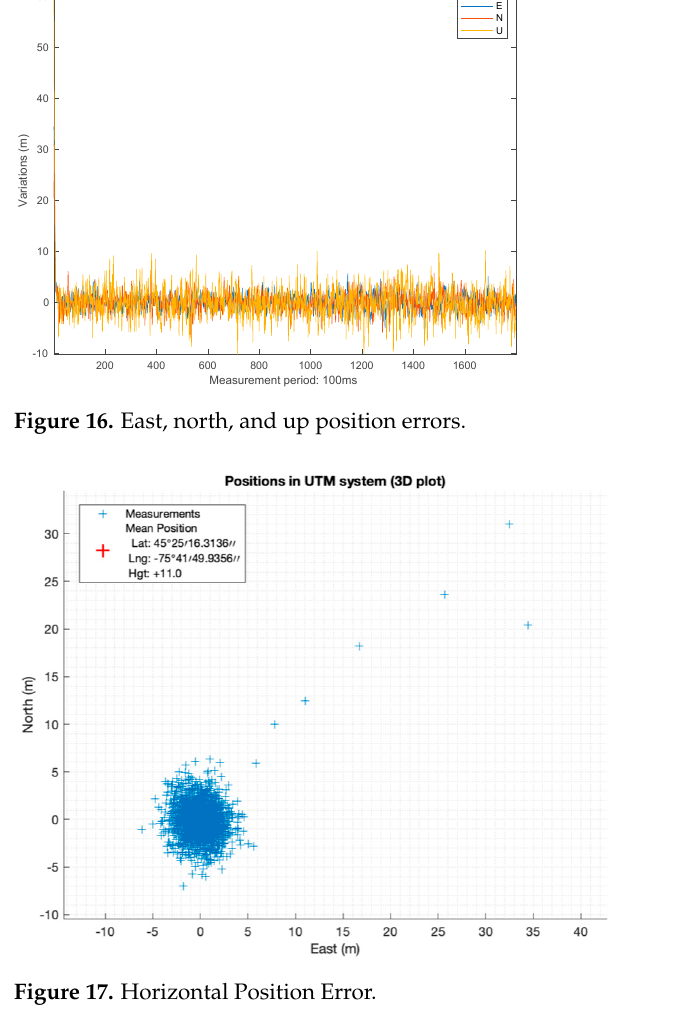
Figure 17. Horizontal Position Error.